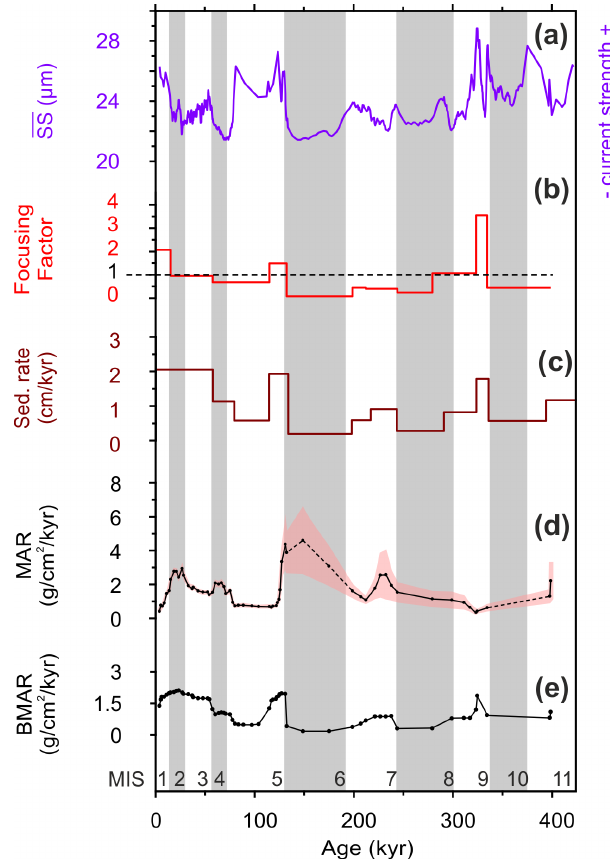
Figure 4. Comparison of sediment mass accumulation rates, fo- cusing factors, bottom current strength and sedimentation rates of core PS97/093-2 for the last 400kyr. (a) Changes in bottom cur- rent strength based on the Sortable Silt grain size record (lilac line, Toyos et al., 2020) compared to (b) focusing factors (red line, black dashed line marks focusing factor = 1); (c) sedimentation rates; (d) 230 Th xs -normalized mass accumulation rate (MAR, black line and dots) and associated errors (2 σ ; pink shadow), which grow with the age of the sample, and dashed lines indicate intervals with un- certainties due to extreme winnowing (Marine Isotope Stage 6) or lack of data (Marine Isotope Stage 10); (e) stratigraphy-based bulk mass accumulation rates (BMARs) obtained by multiplying sedi- mentation rates by dry bulk densities. Numbers in the lower part of the figure indicate Marine Isotope Stage (MIS). Grey bars denote glacial stages according to Lisiecki and Raymo